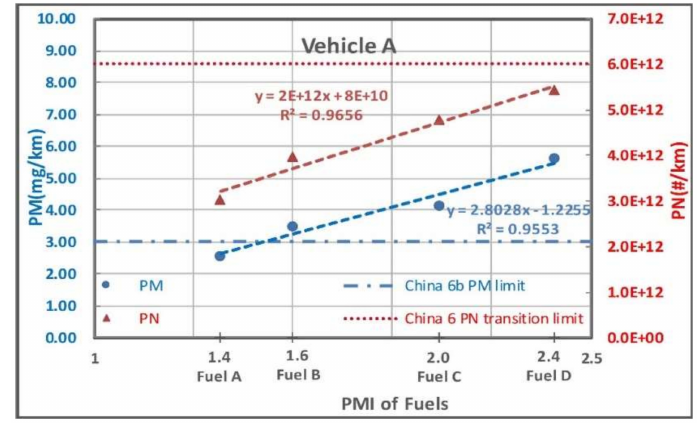
Figure 7. PMI vs. PM and PN emissions from Vehicle